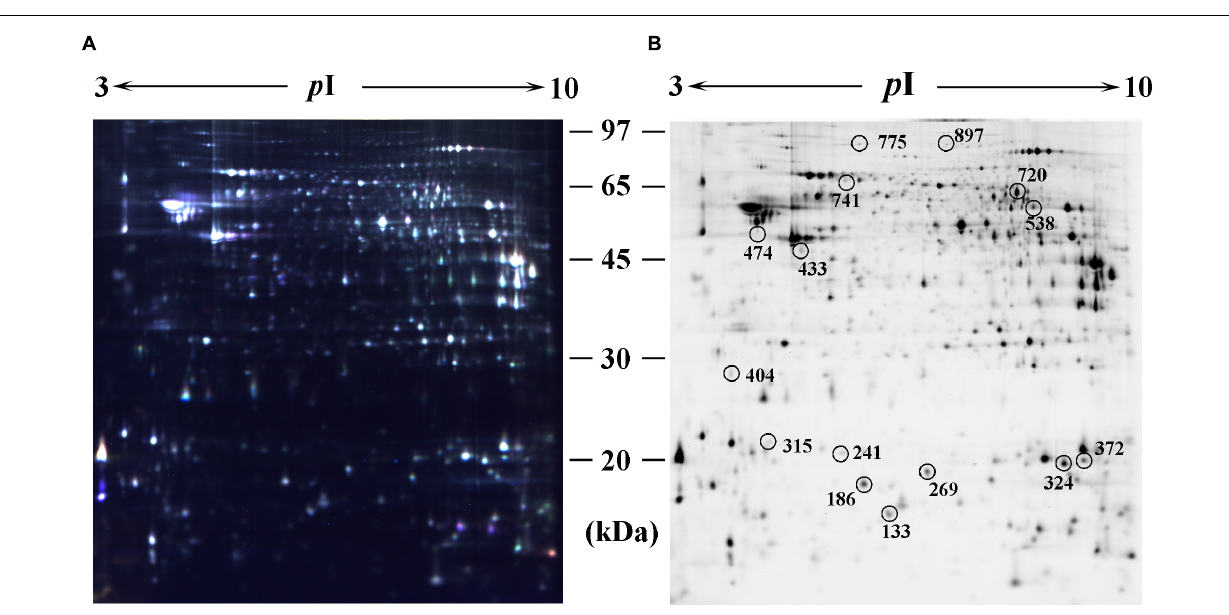
FIGURE 2 | Identification of differentially expressed spots by using 2D-DIGE. Abundant hippocampus proteins were subjected to 2D-DIGE quantitative analysis to identify proteins with differential expression between CP group and control group. (A) Over-lay of cy2-marked loading control, cy3-marked and cy5-marked sample from CP mice or controls ( n = 12). (B) Distribution of differentially expressed protein spots. The samples were separated using IPG gel (pH 3–10, 18 cm) in the first phase and 12.5% SDS-PAGE; 150 ug of protein was used in each gel. The spots showing significant differences between CP mice or controls (see Table 1 ) were labeled in a 2D-DIGE